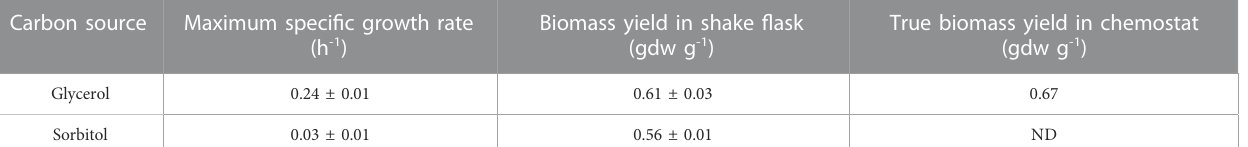
TABLE 1 Maximum speci fi c growth rates and biomass yields during single-substrate growth of the Mut + strain of K. phaf fi i on glycerol and sorbitol. The true biomass yield in the chemostat was determined by fi tting the variation of the speci fi c substrate consumption rate with D to Pirt ’ s model.